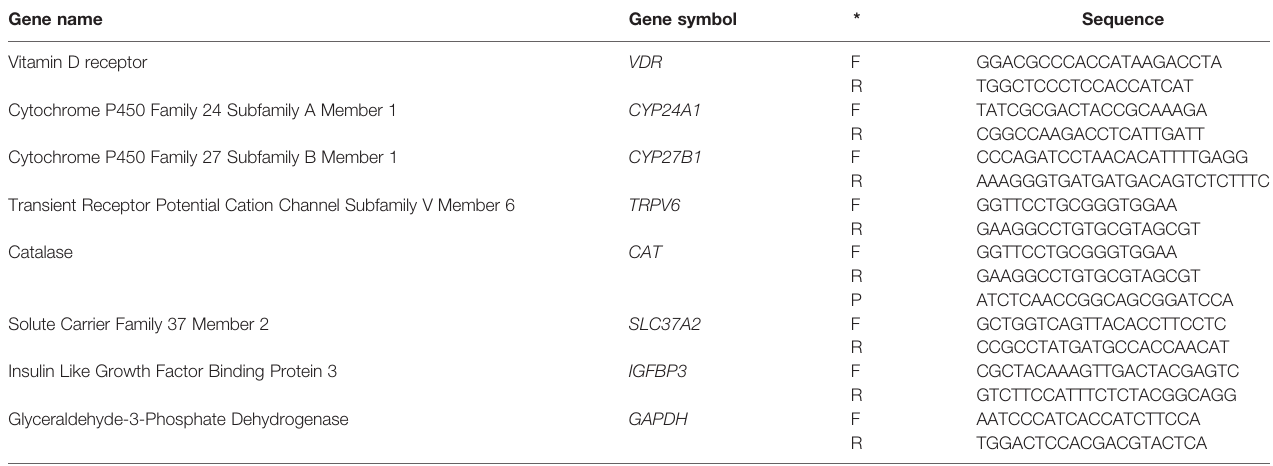
TABLE 1 | Overview of primer and probe sequences used for